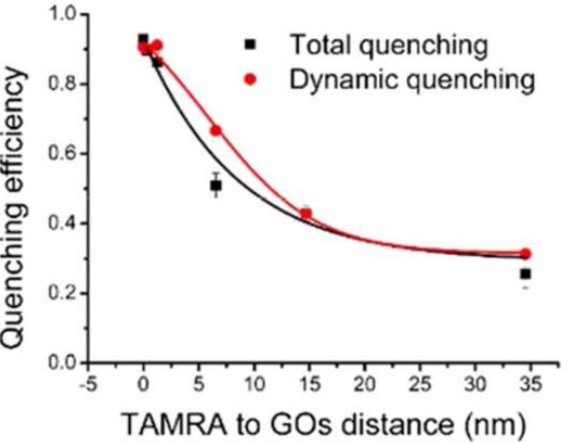
Figure 14. The effect of the distance between TAMRA and GO on the quenching efficiency of GO. Reprinted with permission from [81]. Copyright 2018, American Chemical Society.